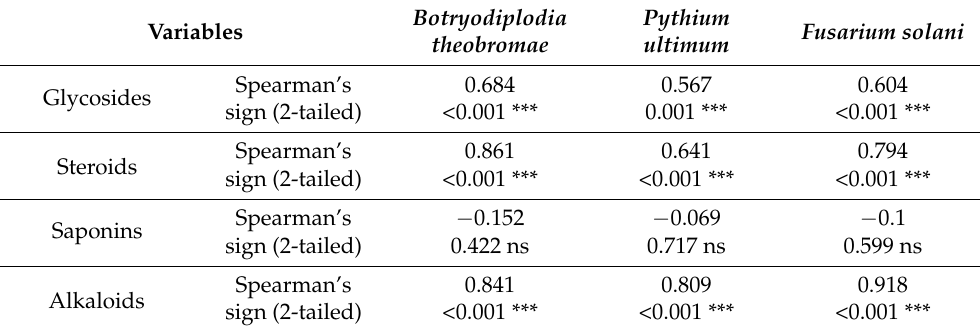
Table 3. Spearman’s rank correlation between glycosides, steroids, saponins, and alkaloids among the different cyanobacterial and algal strains studied. Differences were assessed using the Kruskal–Wallis test.